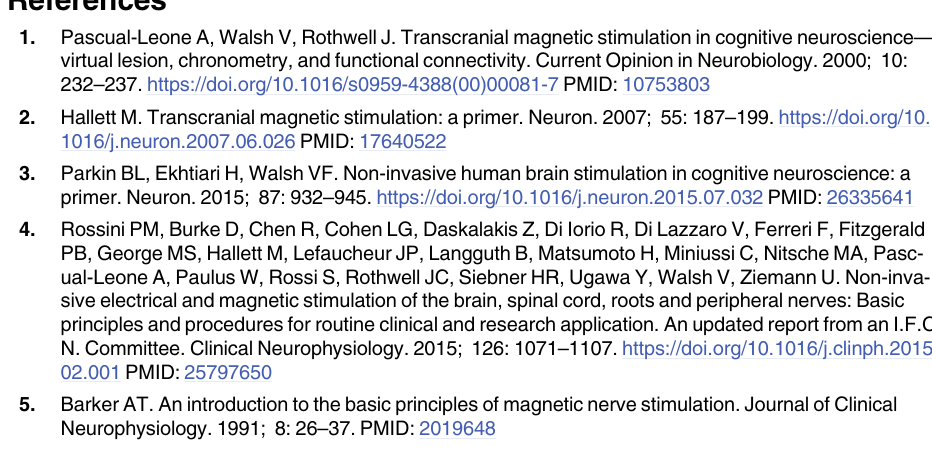
S1 Fig. Brain activation maps for a single subject and group subjects. (A) A brain activation map in one representative subject (the same as Figs 4, 5 and 7) shown in a transverse section of MNI space. Triangles indicate the central sulcus of the subject. The color scale represents t- value. The activation was present over the precentral hand knob. (B) A brain activation map of the group